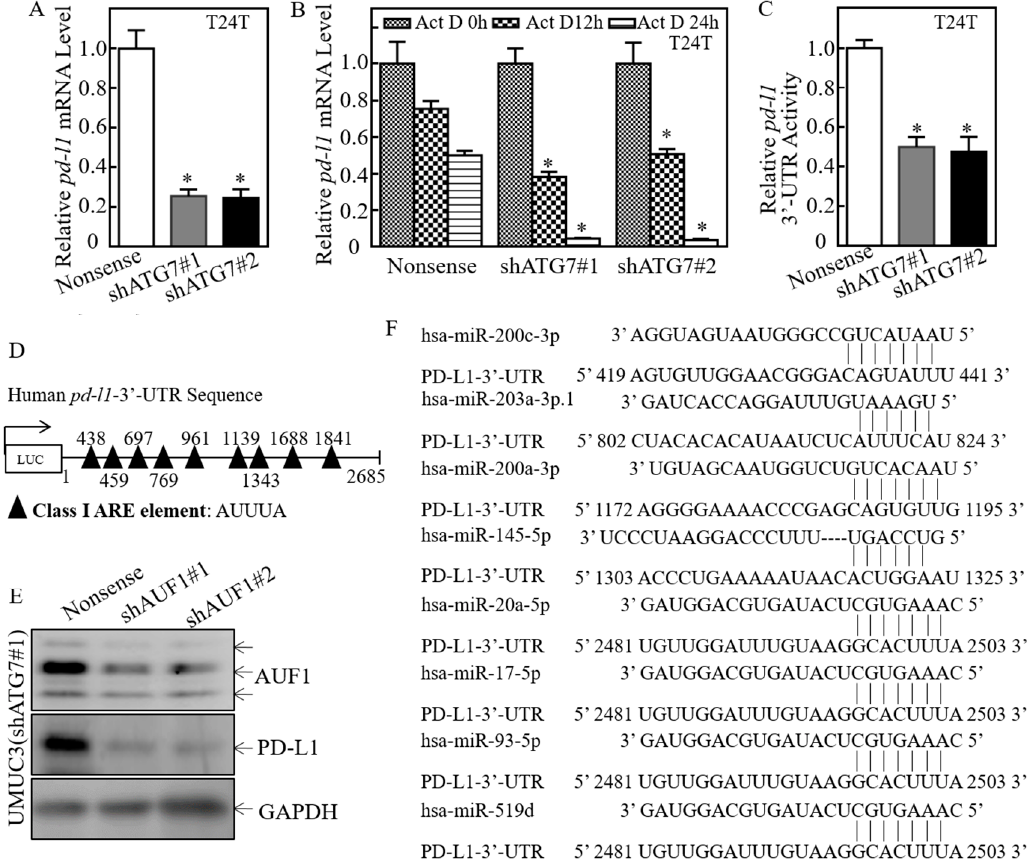
Figure 2. ATG7 inhibition destabilized pd-l1 mRNA by attenuating its 3 ′ UTR activity in human BC cells. ( A ) Real-time PCR was applied to compare the mRNA levels of pd-l1 among T24T(shATG7#1), T24T(shATG7#2) and T24T(Nonsense) cells, and gapdh was used as internal control. ( B ) T24T(shATG7#1), T24T(shATG7#2), and T24T(Nonsense) cells were seeded into 6-well plates. After synchronization, the cells were used to determine pd-l1 mRNA stability in the presence of Actinomycin D (Act D) by using Real-time PCR. gapdh was used as internal control. ( C ) The pMIR- pd-l1 3 ′ -UTR reporter was transiently transfected into the indicated cells and luciferase activity of each transfectant was evaluated. The luciferase activity was presented as a relative to nonsense transfectant with normalized by using pRL-TK as an internal control. The bars show mean ± SD from three independent experiments. The symbol (*) indicates a significant decrease in T24T(shATG7) cells as compared to nonsense transfectant (* p < 0.05). ( D ) The predicted Class I ARE element on the 3 ′ -UTR of pd-l1 mRNA. ( E ) Cell lysates extracted from the indicated cells were subjected to Western Blot to determine AUF1, and PD-L1 protein expression, GAPDH was used as a protein loading control. ( F ) The potential microRNAs binding sites in 3 ′ -UTR of pd-l1 mRNA were analyzed by the TargetScan, Pictar and miRANDA database.